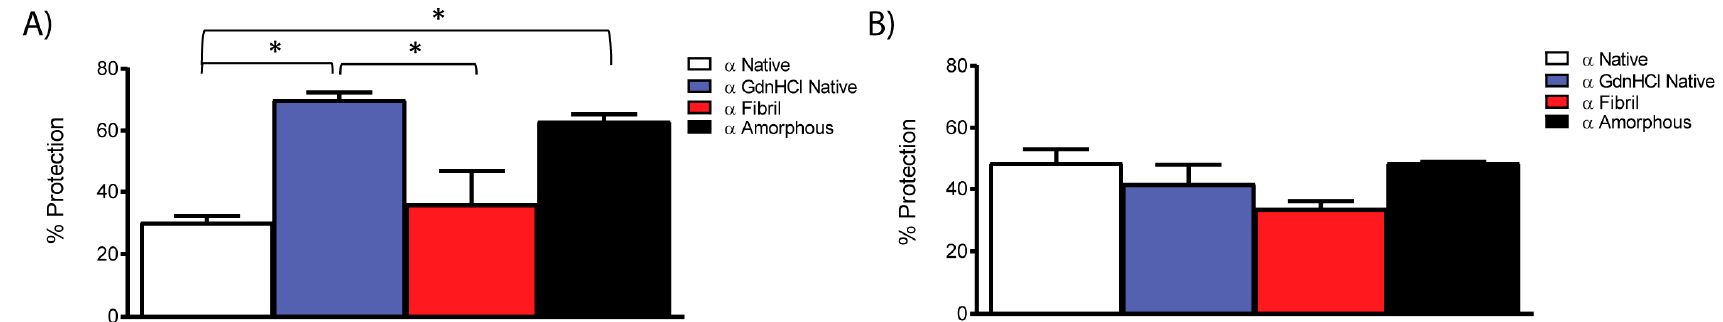
Figure 3. Chaperone protection provided by native, fibrillar and amorphous α -crystallin species against the ( A ) amorphous aggregation of reduced insulin, 250 µ g/mL in 0.1 M sodium phosphate, pH 7.4 and 20 mM DTT at 37 ◦ C (0.9 chaperone: 1.0 insulin on a molar basis); and ( B ) fibrillar aggregation of RCM- κ -casein, 400 µ g/mL incubated at 37 ◦ C for 22 h in the presence of various native, amorphous and fibrillar chaperone species (0.5 chaperone: 1.0 RCM κ -casein on a molar basis) and monitored via ThT fluorescence. The percentage of protection provided by each chaperone is calculated from the difference between the maximal light scattering or fluorescence of the target protein alone and the target protein in the presence of the stated concentrations of α -crystallin. Results are mean ± SE of the percentage protection given by chaperones for three experiments; p- values, derived by one-way ANOVA with Tukey post-test, are * p <0.05, ** p <0.01, *** p <0.001.